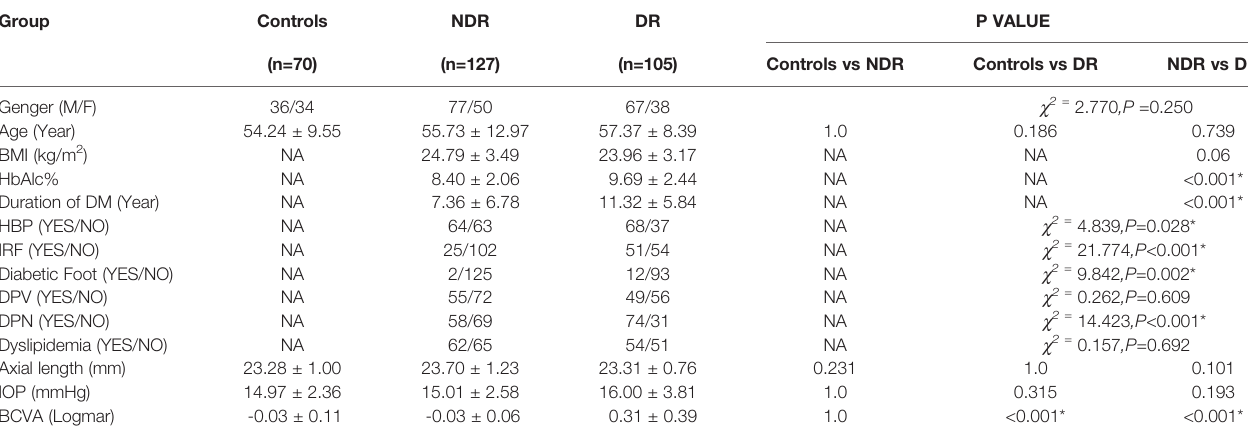
TABLE 1 | Subject